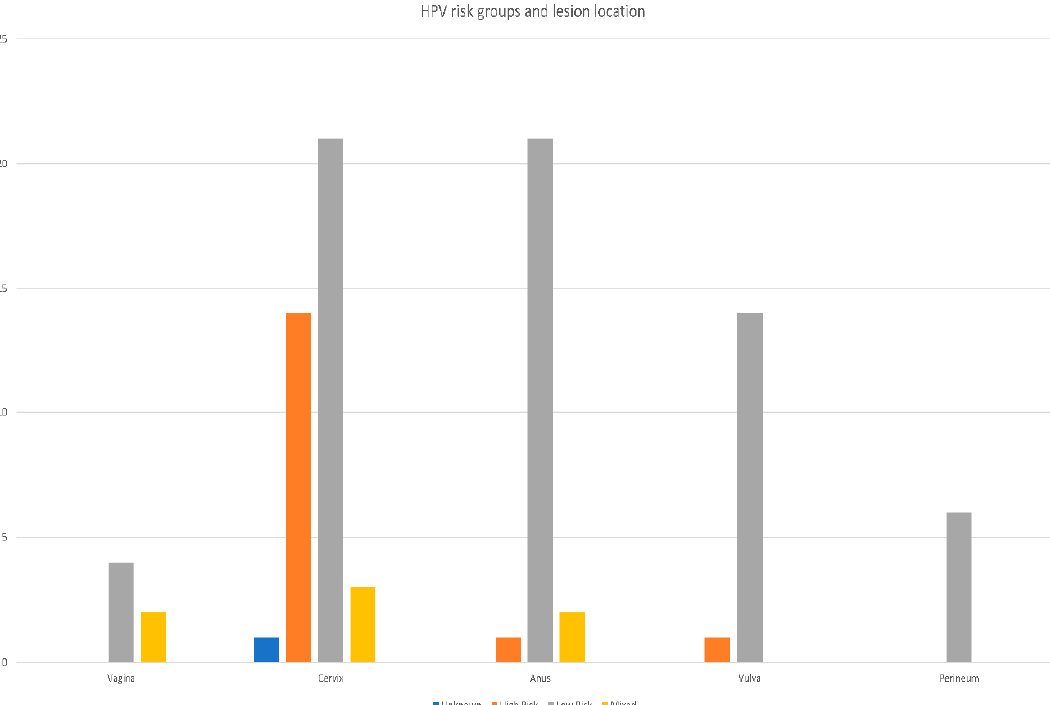
Figure 2. HPV risk groups in relation to anatomical location.